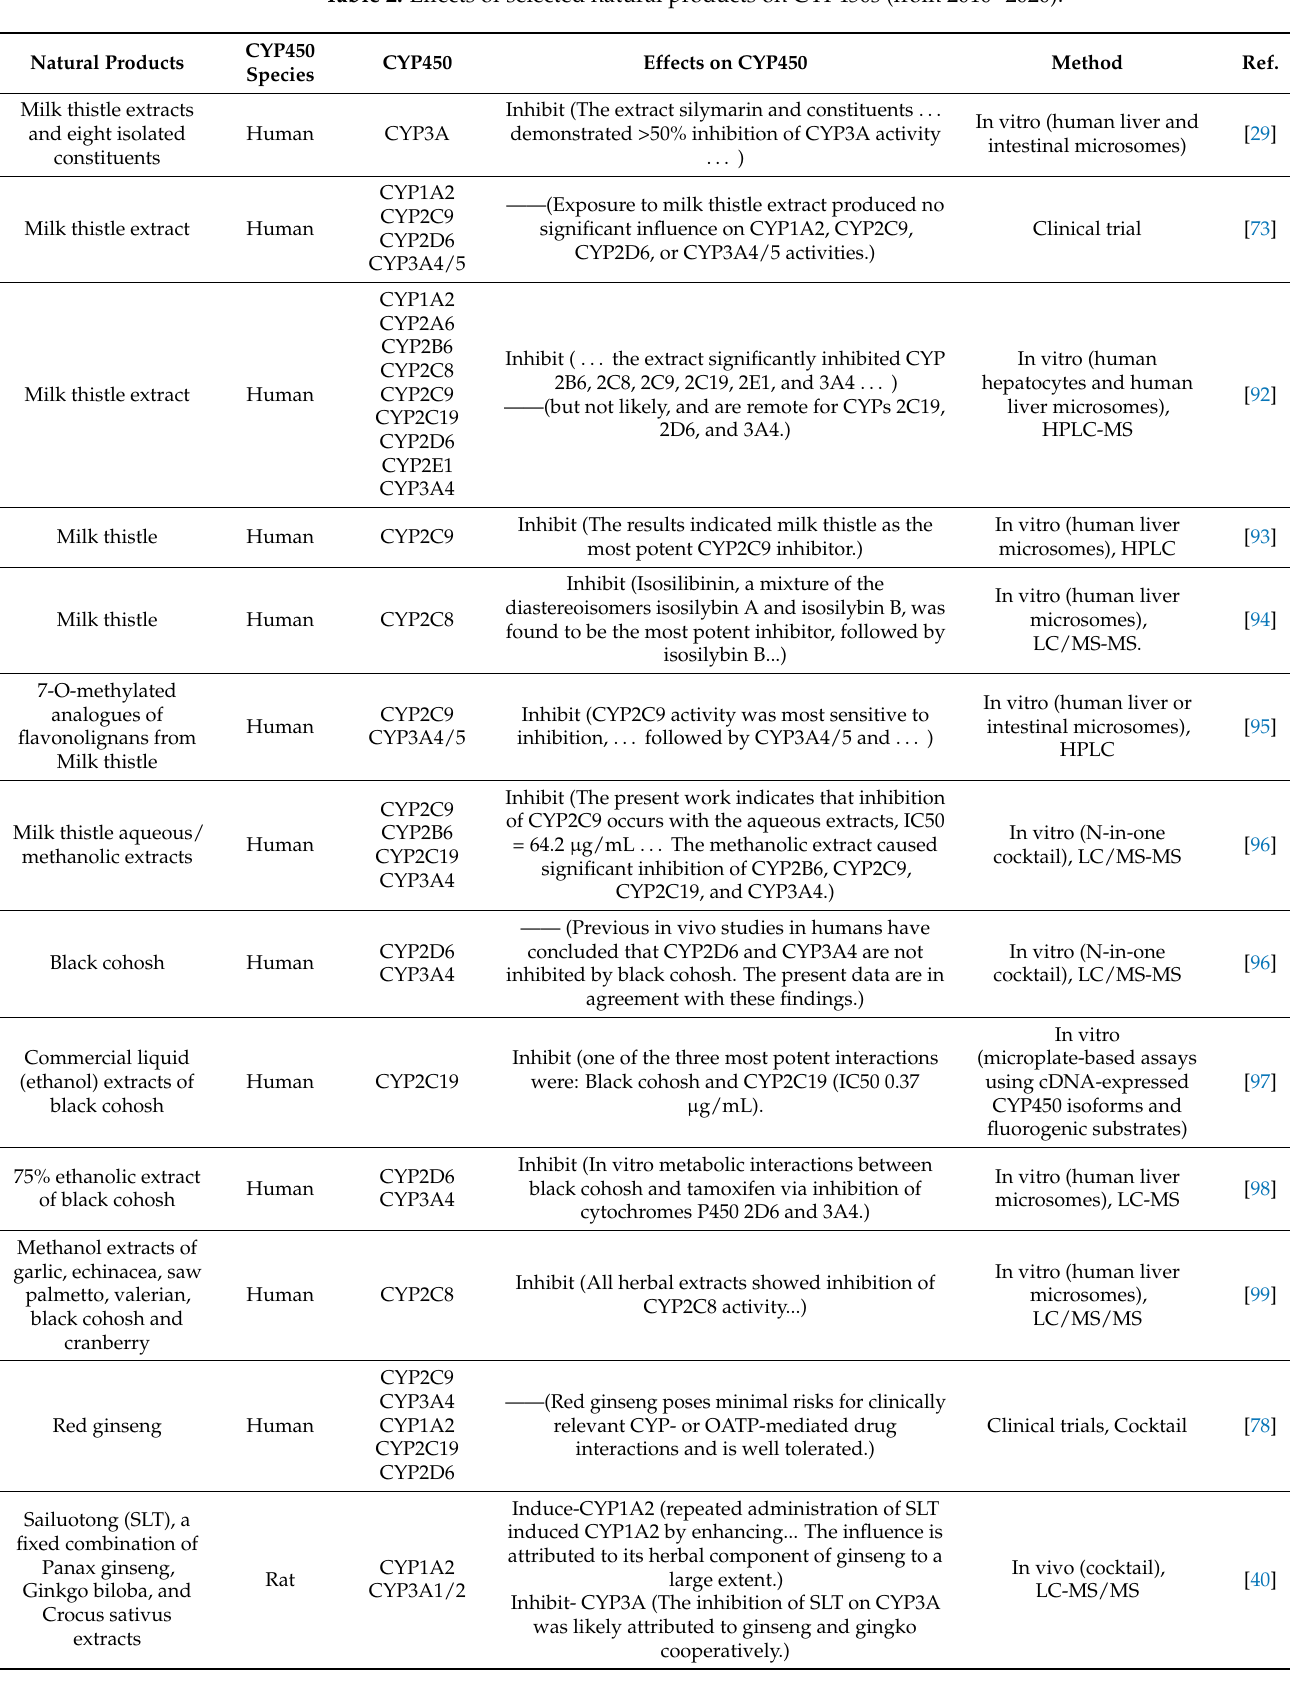
Table 2. Effects of selected natural products on CYP450s (from